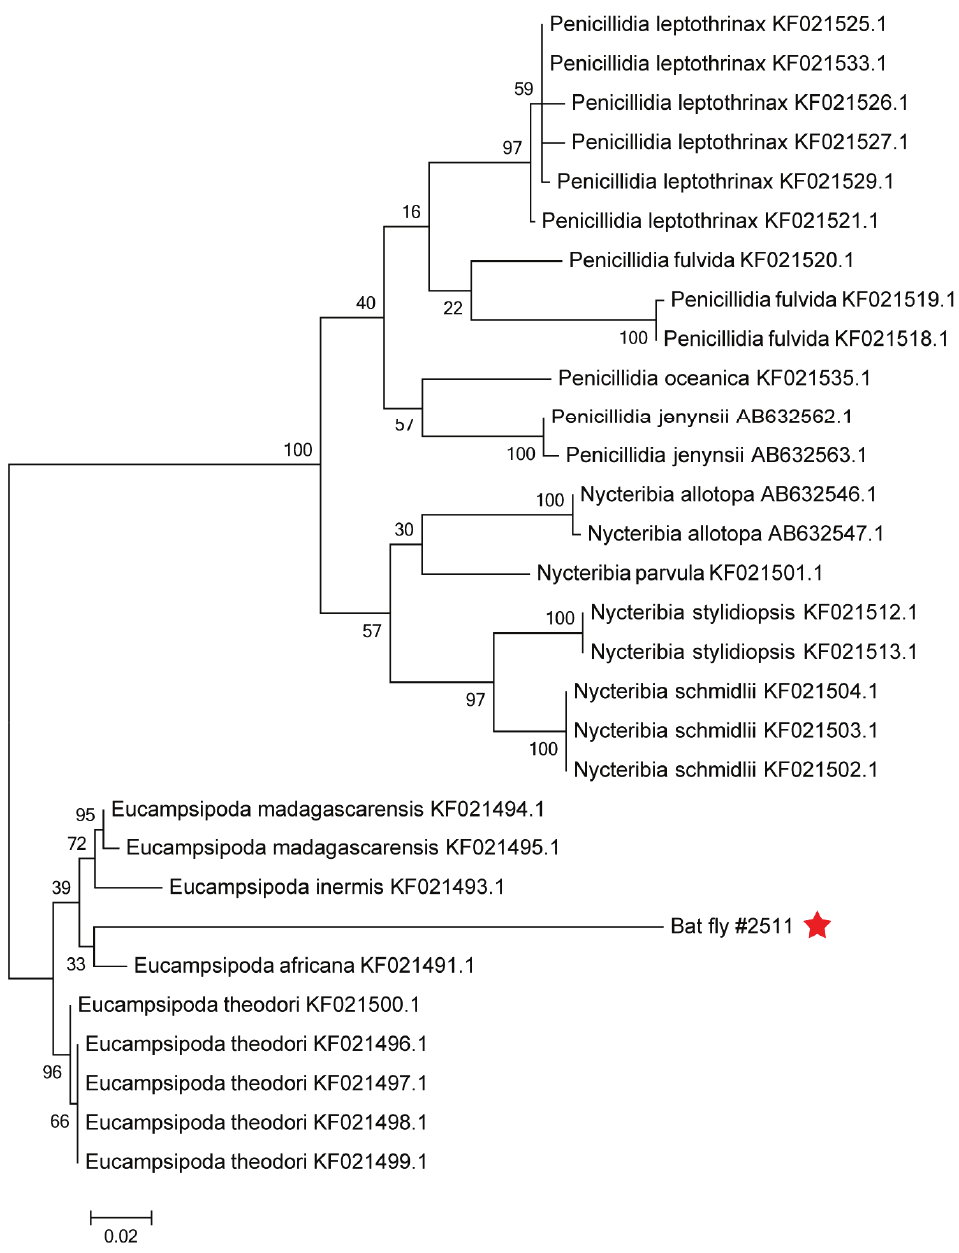
Figure 4. Phylogenetic tree (Maximum Likelihood) based on cytochrome c oxidase subunit I sequences. The COI partial sequence from the bat fly sequenced from this study is indicated by the red star.